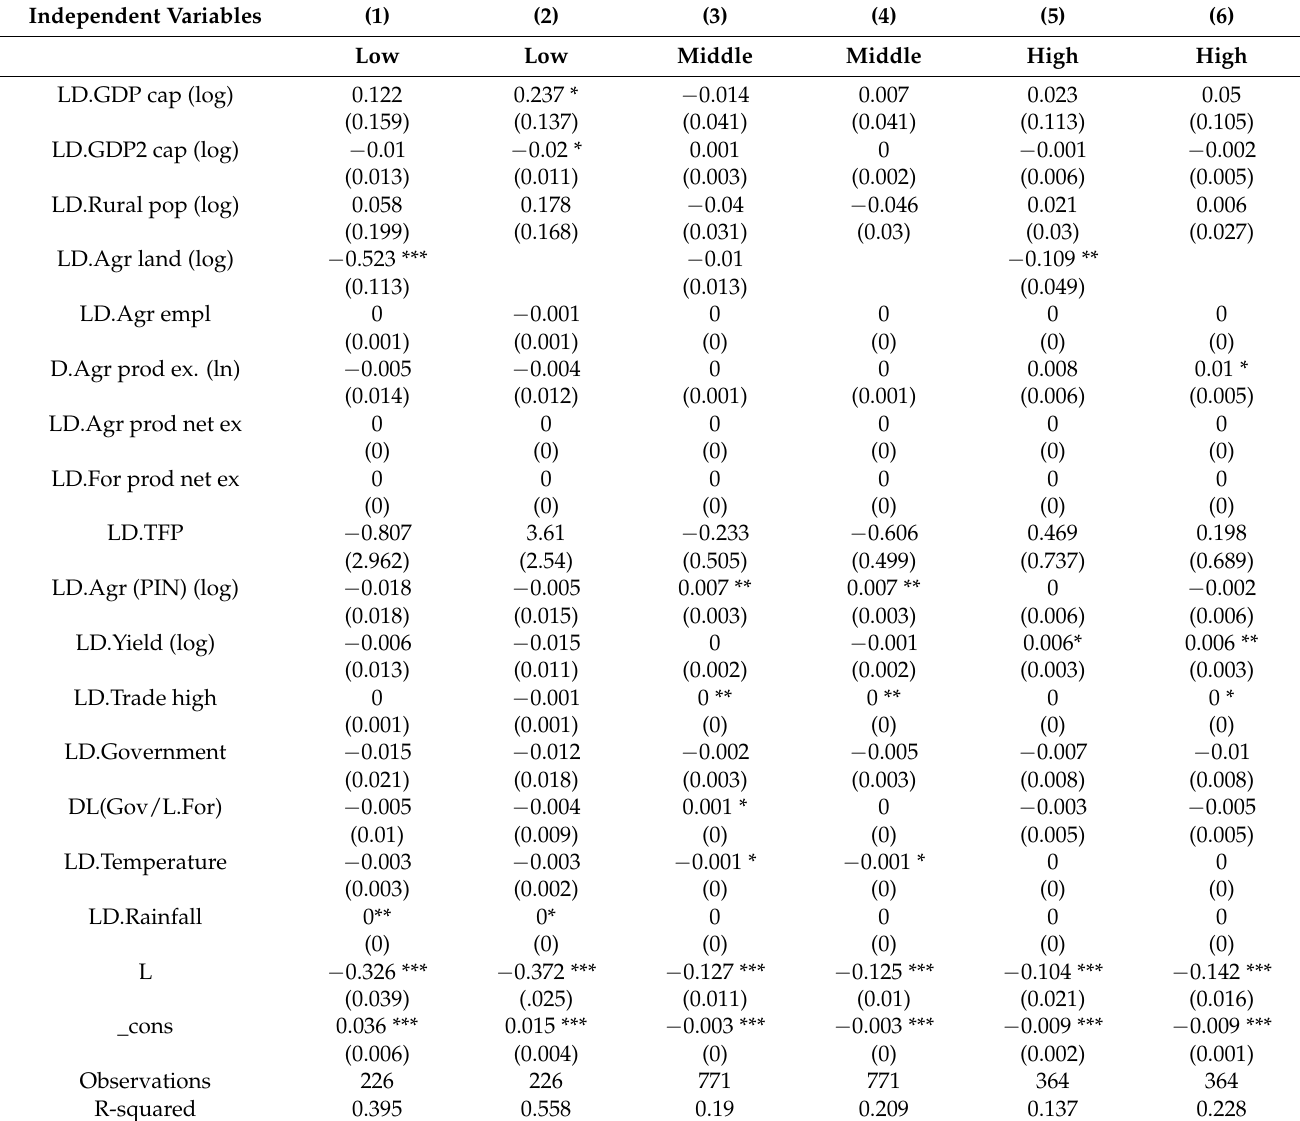
Table A7. Short run, income clusters, net agricultural exports and net exports of forests products as additional control variables. Independent Variables